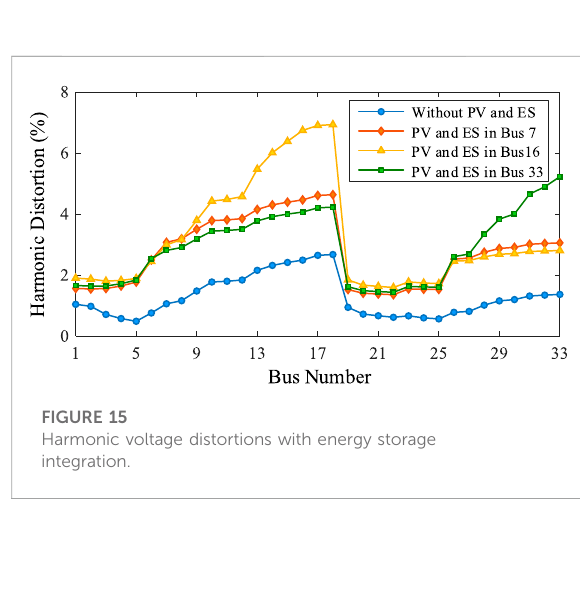
FIGURE 14 Harmonic voltage distortions without energy storage integration.